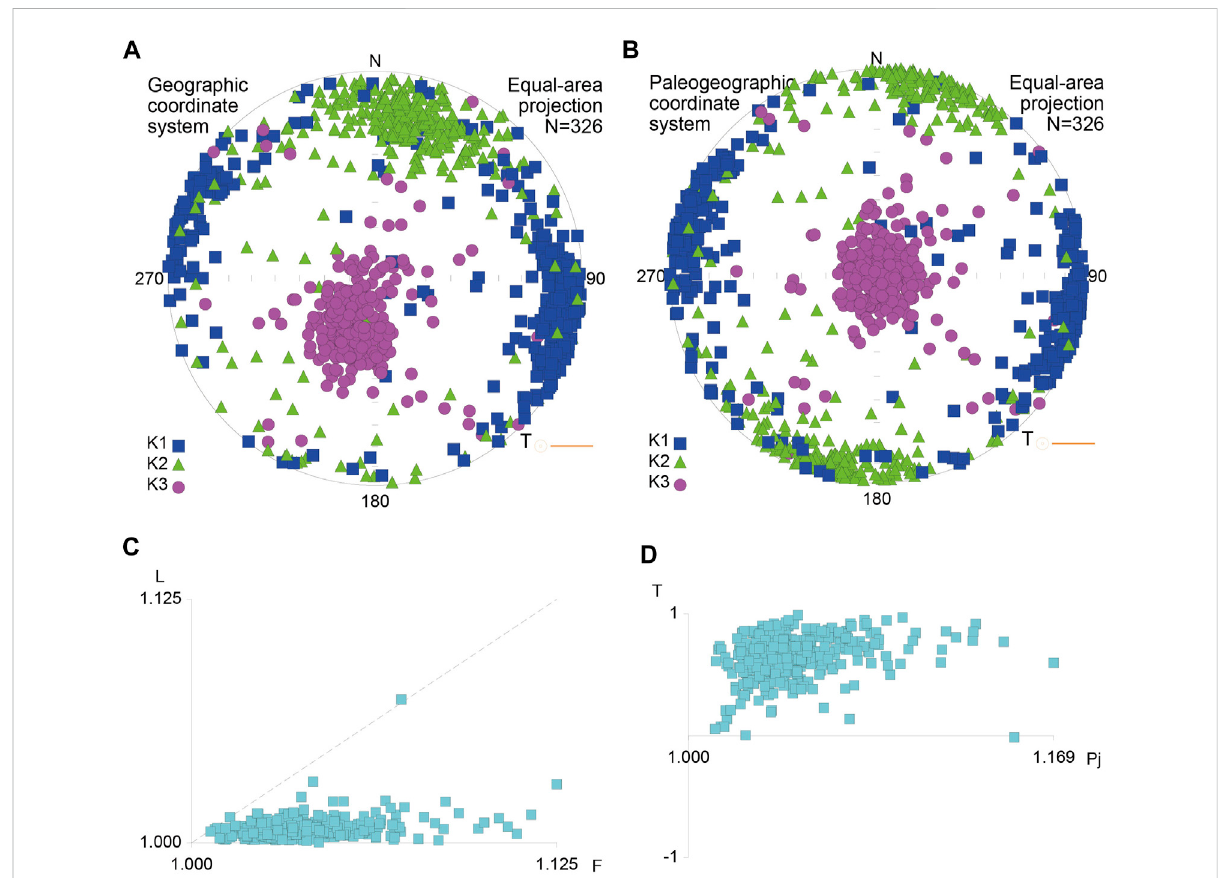
FIGURE 8 Anisotropy of magnetic susceptibility (AMS) results from the Yengisar section. Stereographic projections (lower hemispheres) of AMS orientations before (A) and after (B) tilt correction. (C) , F (foliation)-L (lineation) diagram. (D) , P j – T (corrected AMS degree versus AMS shape parameter)